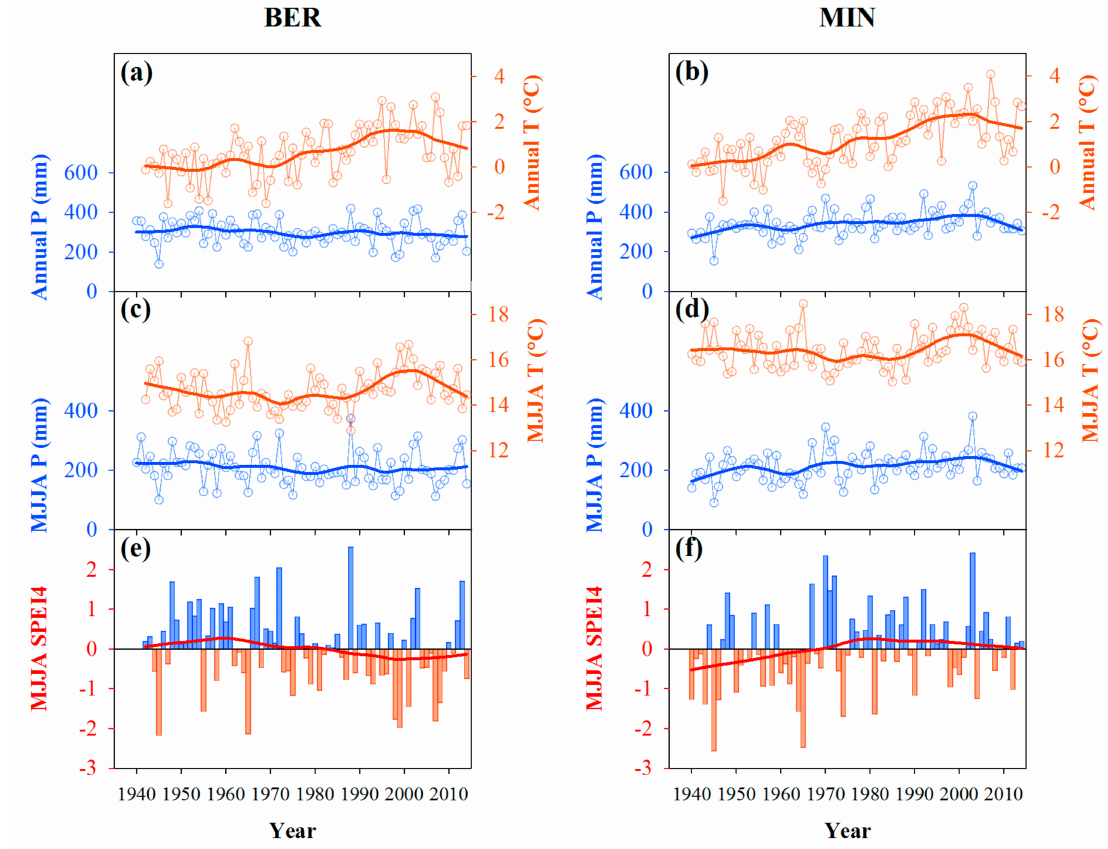
Figure 3. Regional climate trends in BER (left panels) and MIN (right panels) for the period 1940–2014. ( a , b ) Annual (upper panels) and ( c , d ) growing season (May–August; middle panels) long-term changes in total precipitation (blue lines) and mean temperature (orange lines). The data were obtained from the nearest meteorological station to each sampling site (Shira station for BER; Minusinsk station for MIN). ( e , f ) Growing season (May–August) Standardized Precipitation-Evapotranspiration Index (MJJA SPEI4). Positive values indicate wet years (blue bars), while negative values correspond to dry years (orange bars). Temporal trends in climate records (thick lines) are smoothed by LOESS fitting (span = 0.25). Significant (positive) linear trends over time were detected in mean annual temperature at both sites (BER: b = 0.03 ◦ C year − 1 , p < 0.001; MIN: b = 0.03 ◦ C year − 1 , p < 0.001) as well as in